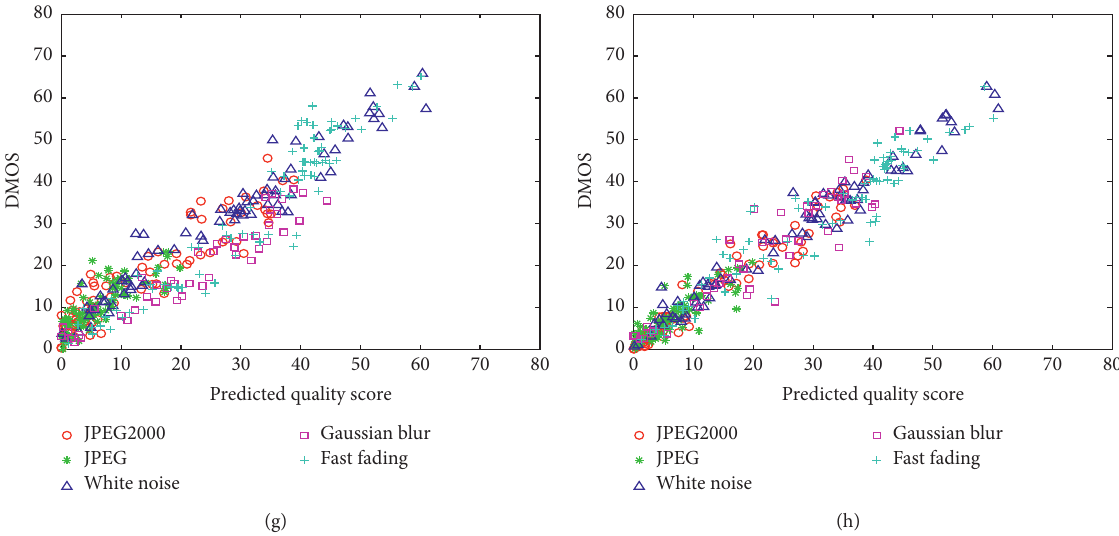
Figure 4: Scatter plots of the predicted quality scores against the subjective DMOS values for the eight methods. (a) PSNR. (b) MS-SSIM [55]. (c) Benoit et al.’s method [13]. (d) Chen et al.’s method [8]. (e) Zhou and Yu’s method [56]. (f) Fan et al.’s method [41]. (g) Shen et al.’s method [22]. (h) Proposed